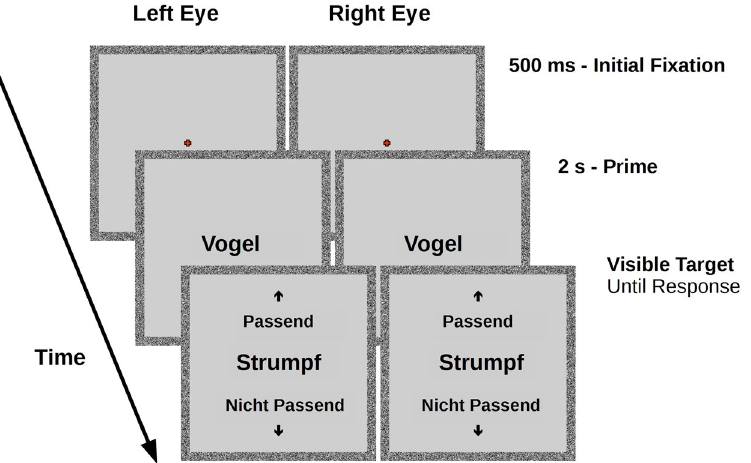
Figure 2. Semantic control trial design. Trials began with a fixation cross, followed by a central prime for 2 s, in an identical manner to bCFS trials. Following the prime, a visible rather than suppressed target word was presented binocularly, accompanied by cues for a semantic congruency task. ‘Up’ indicated that the visible target is congruent with the preceding prime category, ‘down’ indicated that the visible target is incongruent with the preceding prime category. This screen was held until a response was made. Note: to aid illustration, contrast and size of words has been